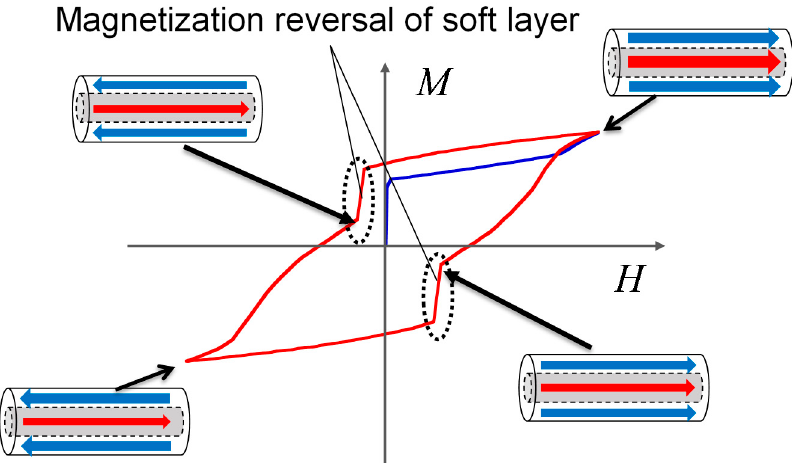
Figure 2. Initial magnetization curve (blue) and minor hysteresis loop (red) of the FeCoV wire.